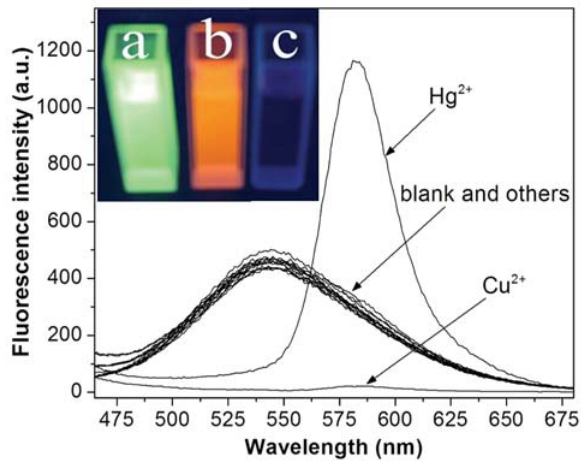
Figure 1. Fluorescence spectra of RD (10 μM) upon addition of va- rious cations (10 μM) in MeCN-H O solution (9/1, 10 mM HEPES 2 buffer, pH 7.2) when excited at 370 nm. Inset: the fluorescence photographs of RD in the absence (a) and presence of Hg 2+ (b) and Cu 2+ (c) in dark-box ultraviolet analyzer when excited at 365 nm.